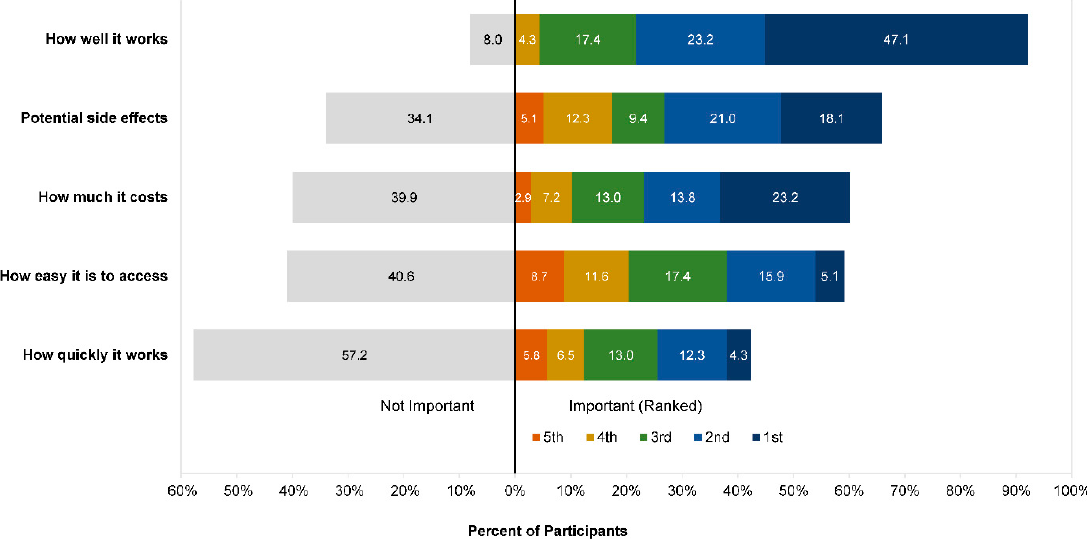
Figure 9. Participant importance rankings for each treatment consideration. “Not important” = percent of participants who did not select the option as important to them, “important” = percent of participants who selected the option as important and the rank they assigned it relative to other considerations (1 = most important to 5 = least